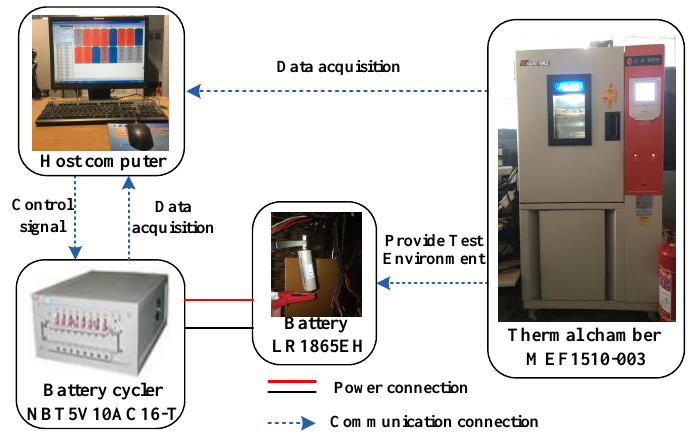
Figure 1. Battery test bench which consists of battery cycler, host computer, lithium-ion battery, and thermal chamber.